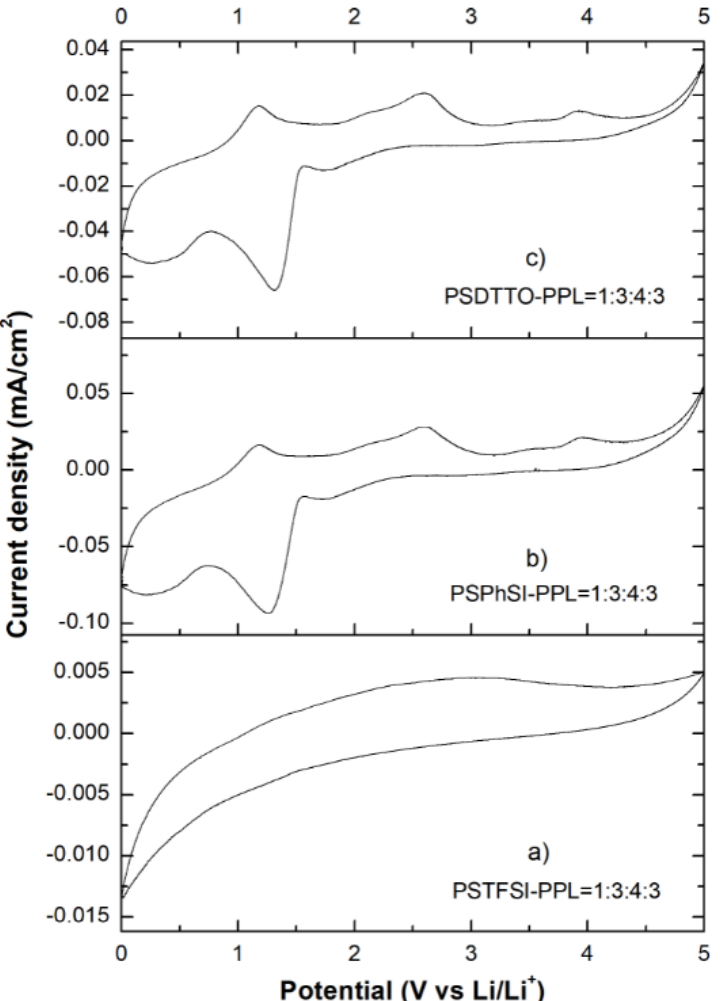
Figure 14. Cyclic voltammetry (CV) curves of the selected electrolyte membranes: ( a ) TFSI–PPL = 1:3:4:3; ( b ) PhSI–PPL = 1:3:4:3; ( c ) DTTO–PPL = 1:3:4:3.